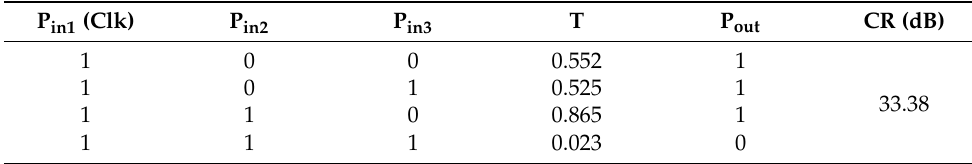
Table 7. Simulation findings for NAND (T th = 0.14). P in1 (Clk)